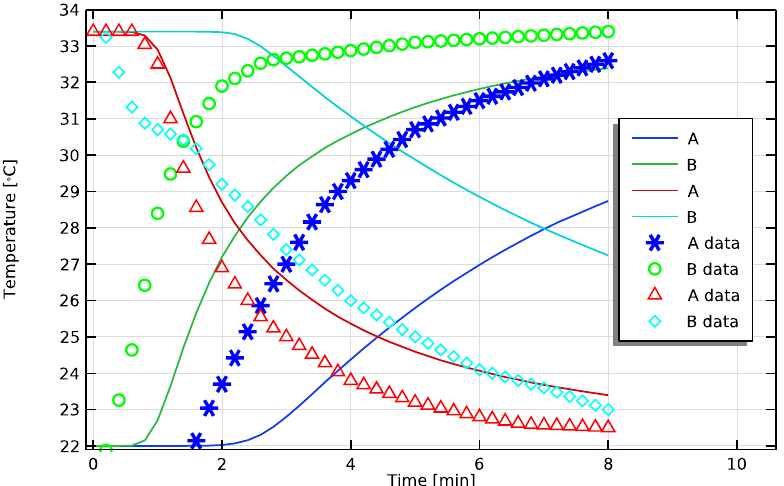
Figure 8. Comparison between measurements and numerical results, at two observation points, A and B, for the heating and cooling stages, for T 0 = 22 °C and T 1 = 33.4 °C. We observed that disturbances in the initial conditions do not have any effect on the Numerous experiments with the numerical model were performed to obtain a better results. The disturbances die out so quickly that they are hardly visible in the graphs. fit than the first attempt, shown in Figure 8, and to investigate the sensitivity to the temperature range. High and low temperatures were changed between 22 °C and 220 °C. data. From the temperature variations, it becomes clear that better fits are obtained for increased temperature